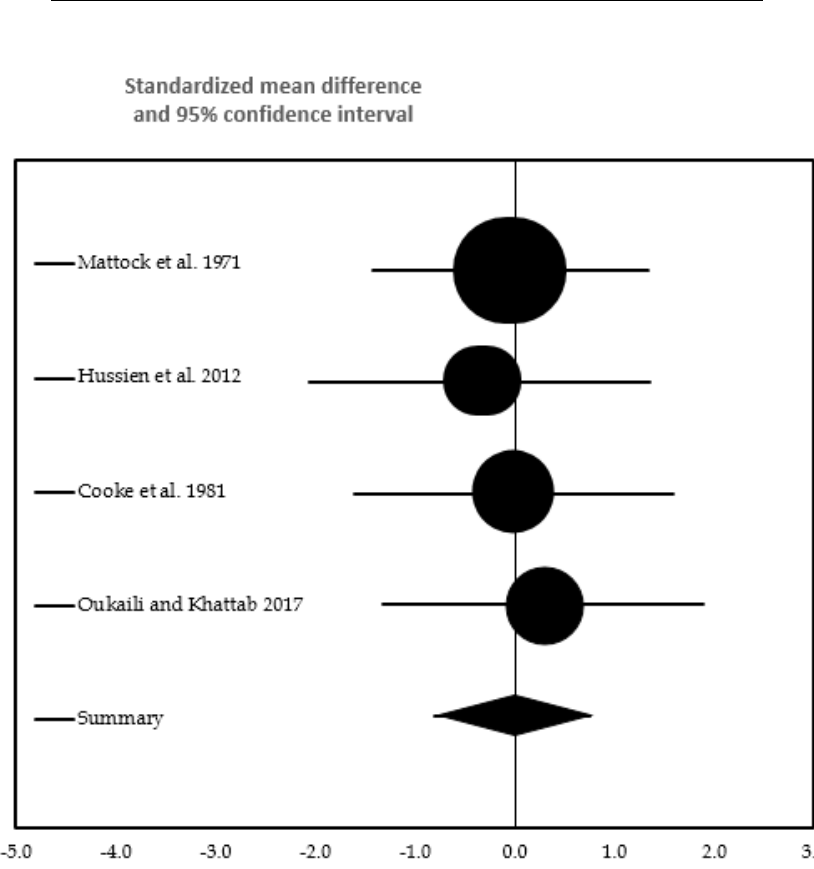
Fig. 5. Effect of different tendon bonding